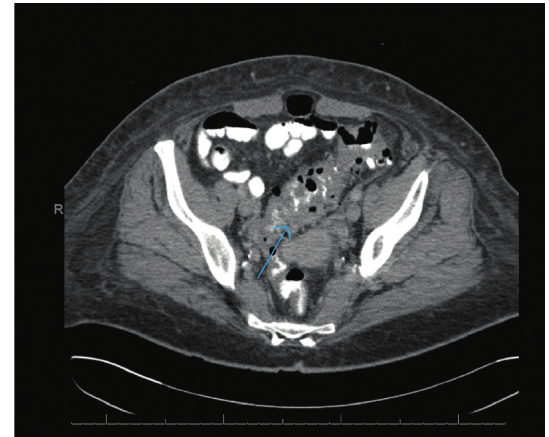
Figure 1: Axial computed tomography of the abdomen and pelvis demonstrating sigmoidcolonic thickening and mild sigmoid colitiswith no evidence of perforation on day 2 of hospitalization (blue